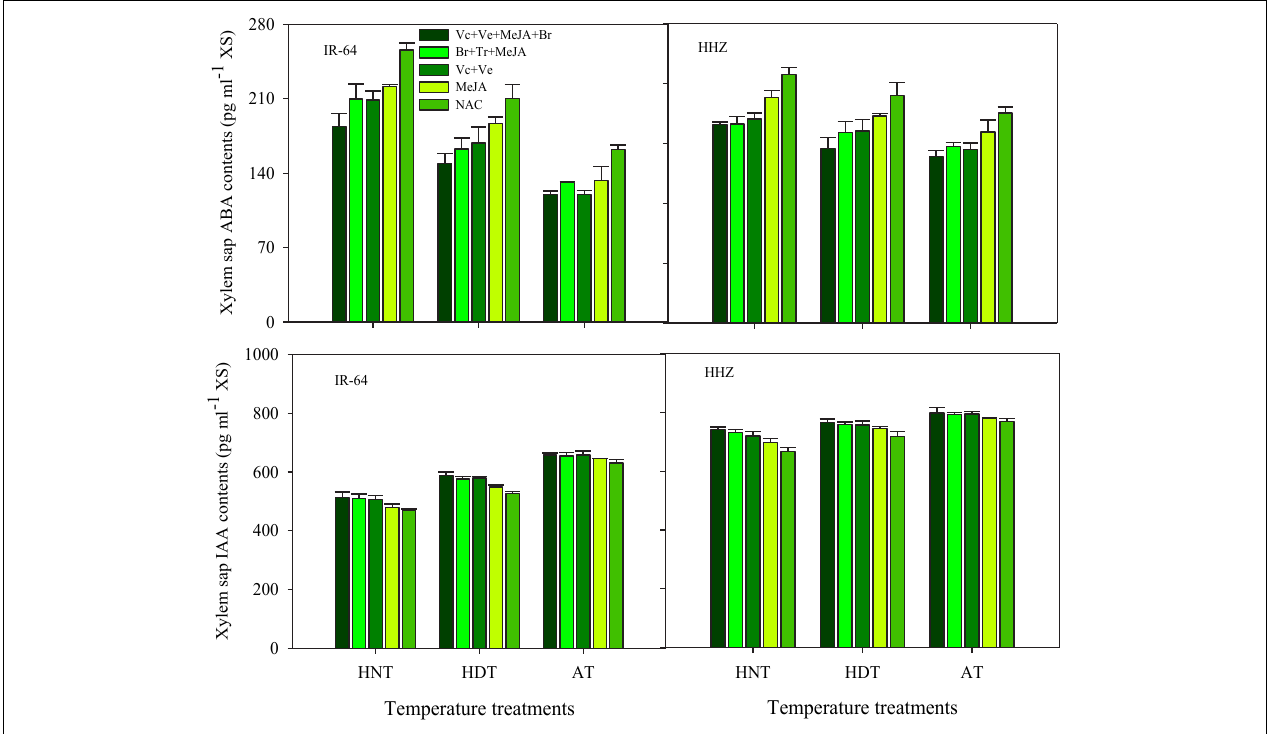
FIGURE 9 | Impact of PGRs on the concentration of abscisic acid (ABA) and indole-acetic acid (IAA) in rice xylem